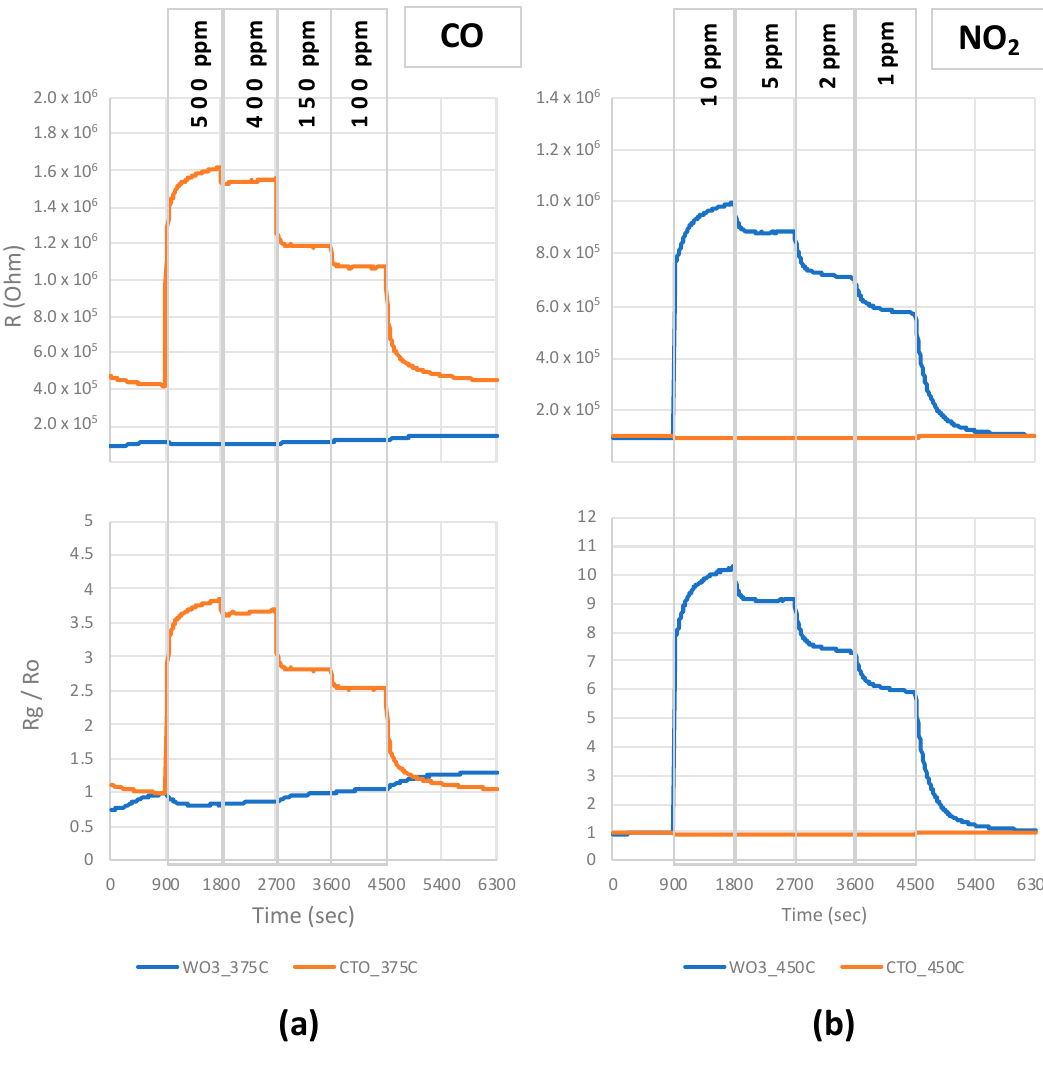
Figure 1. A Multi-MOx sensor response to ( a ) CO at operating T = 375 ° C, and ( b ) NO 2 at operating T = 450 ° C, both in 50% relative humidity air. Top and bottom charts show the raw signal (R) and the corresponding relative response (Rg/Ro), respectively. Blue and orange lines are WO 3 ( n -type) and CTO ( p -type) sensors signal,